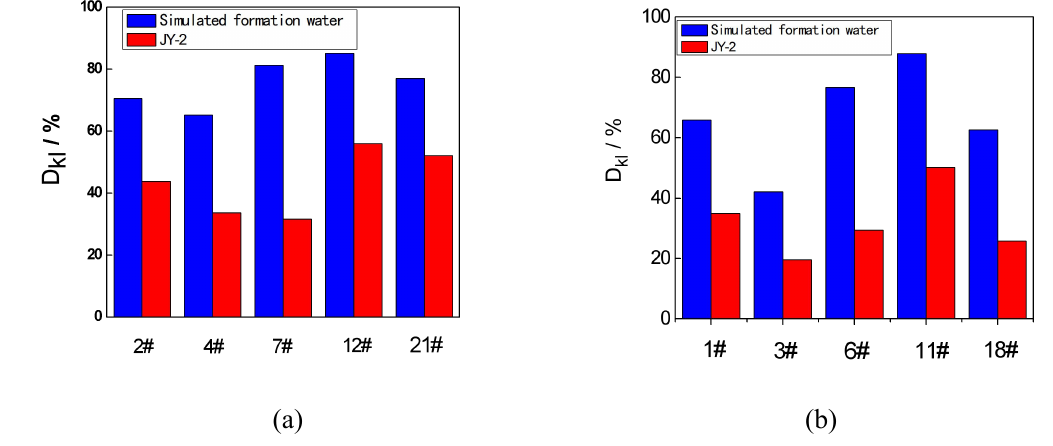
Figure 8—Results of WBI. (a) JY-2. (b)